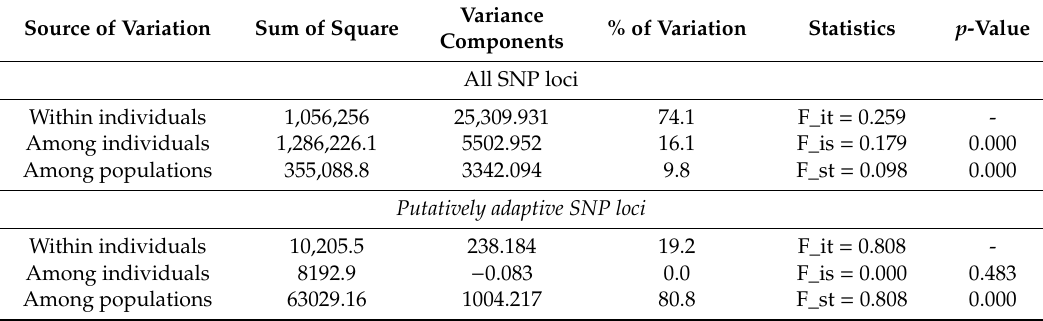
Table 6. Molecular analysis of variance for the all SNP loci and putatively adaptive SNP loci of five giant tiger shrimp Penaeus monodon broodstock populations collected from di ff erent Indo-Pacific